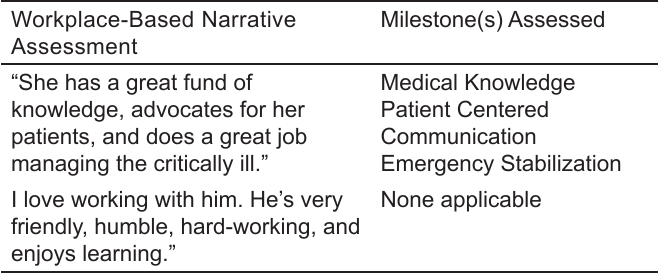
Table 1. Example of a workplace-based narrative assessment identifying emergency medicine milestone